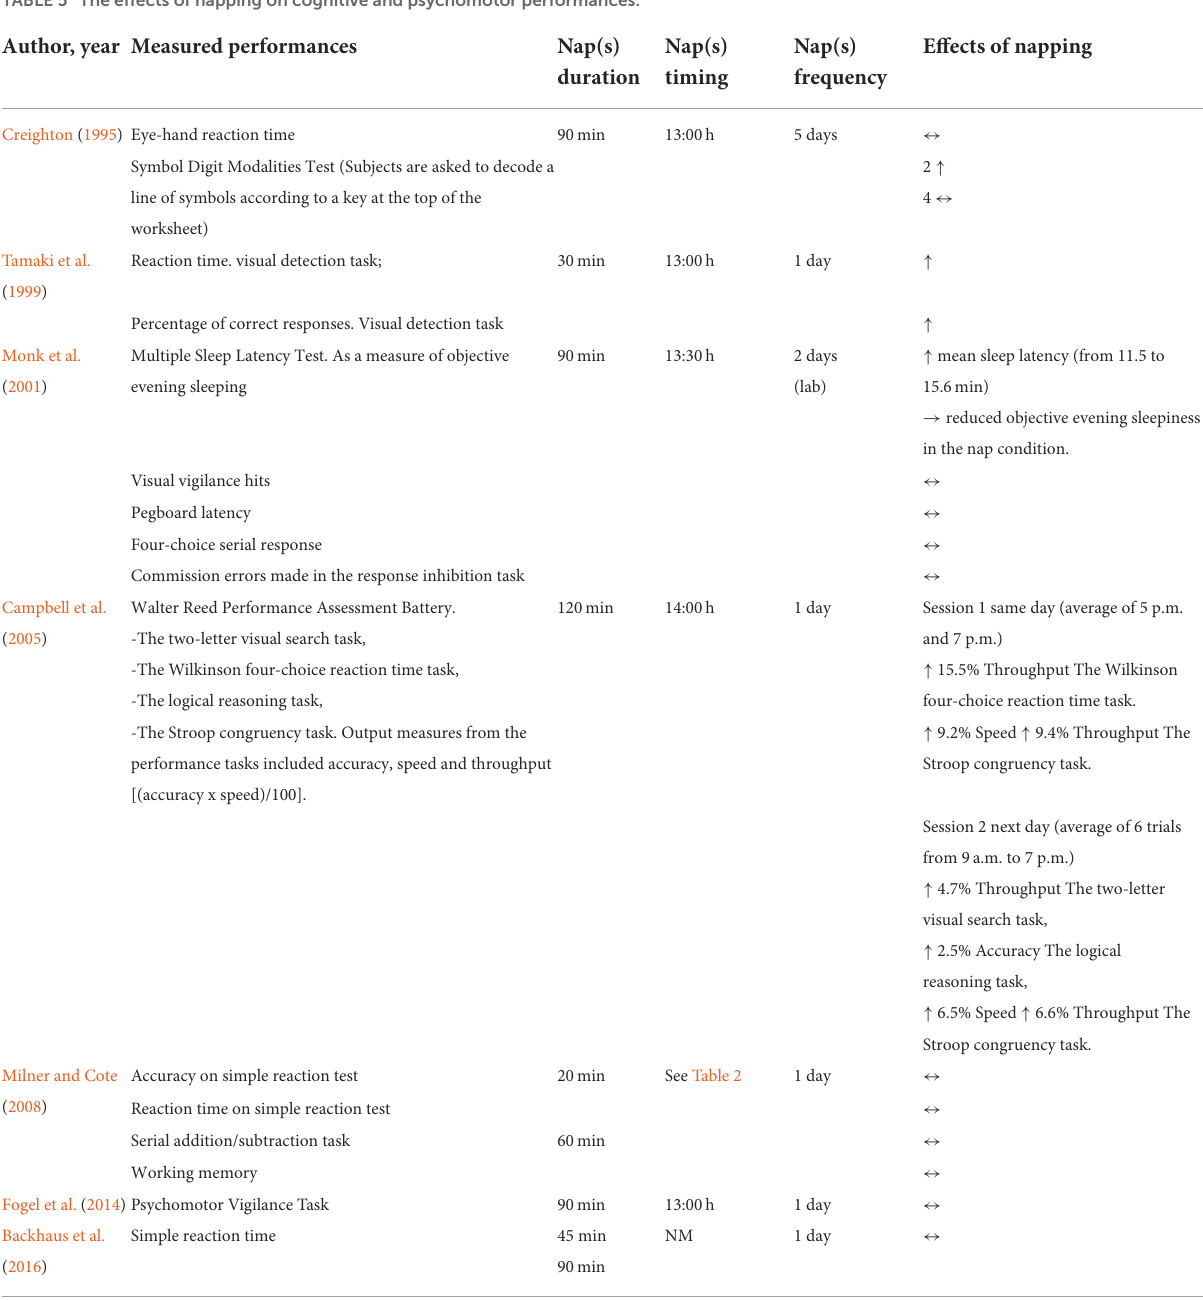
TABLE 5 The effects of napping on cognitive and psychomotor performances. Author, year Measured performances Nap(s)